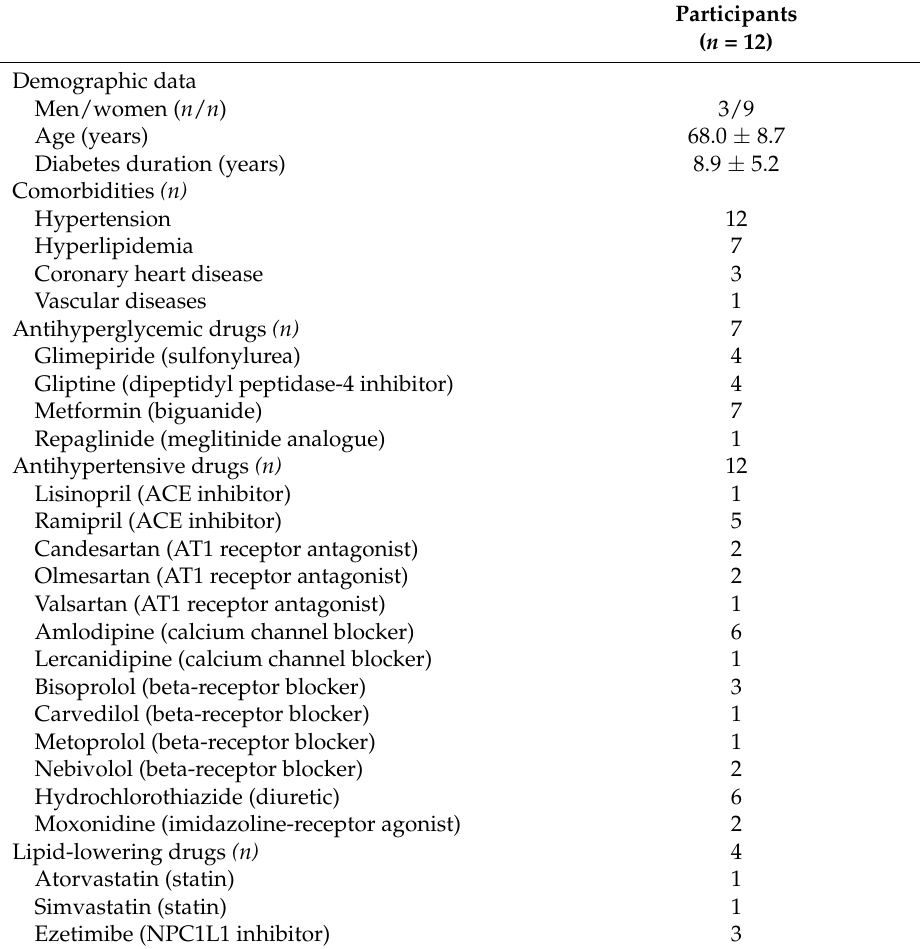
Table 3. Demographic and clinical